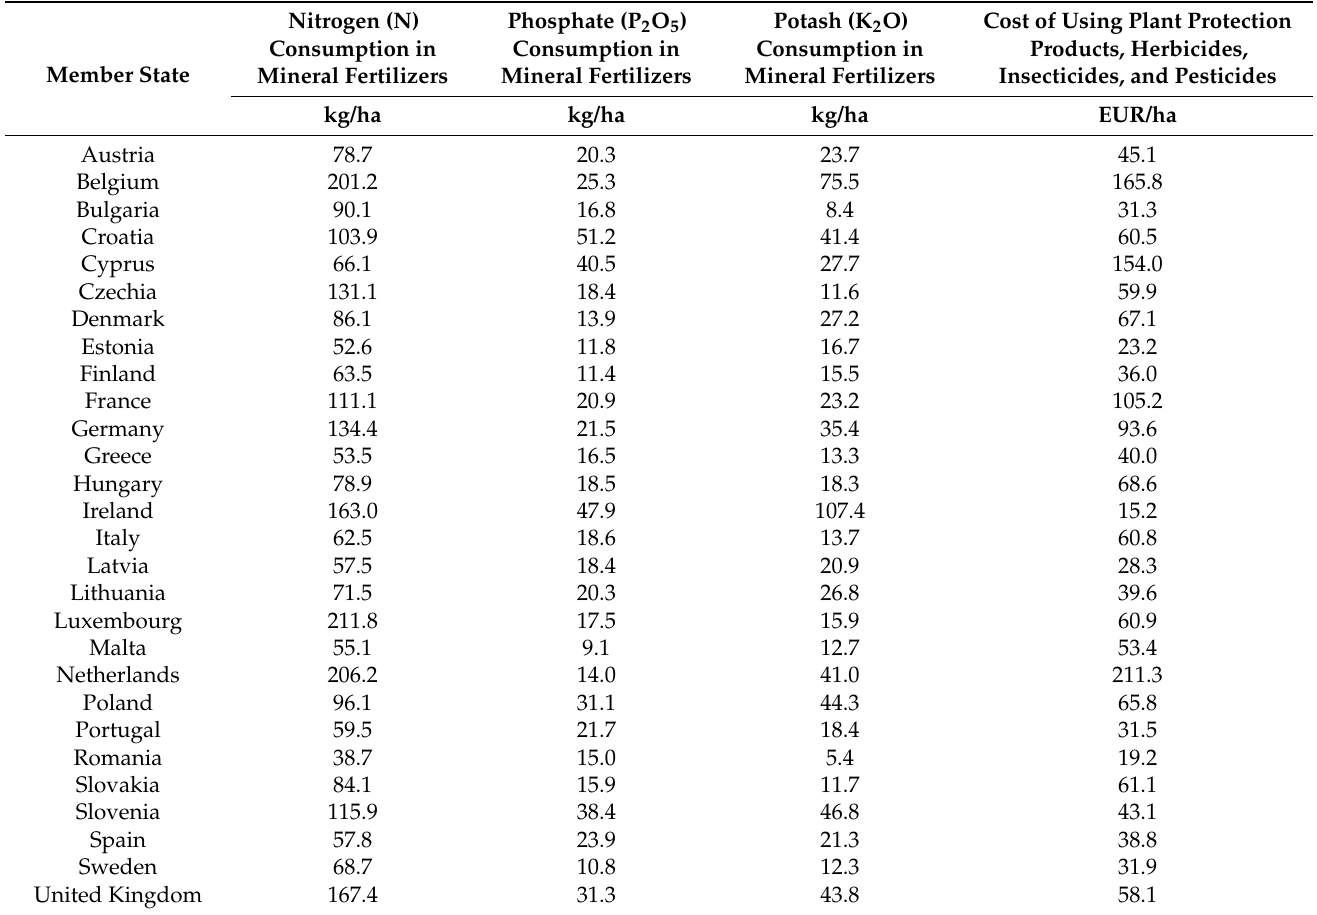
Table 1. Consumption of mineral fertilizers and plant protection products, herbicides, insecticides, and pesticides per 1 ha in the EU member states from 2010 to